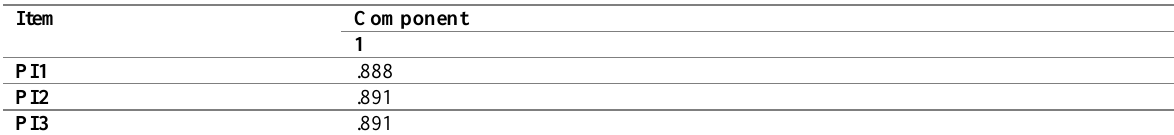
Table 9: Exploratory Factor Loadings of the Purchase Intention